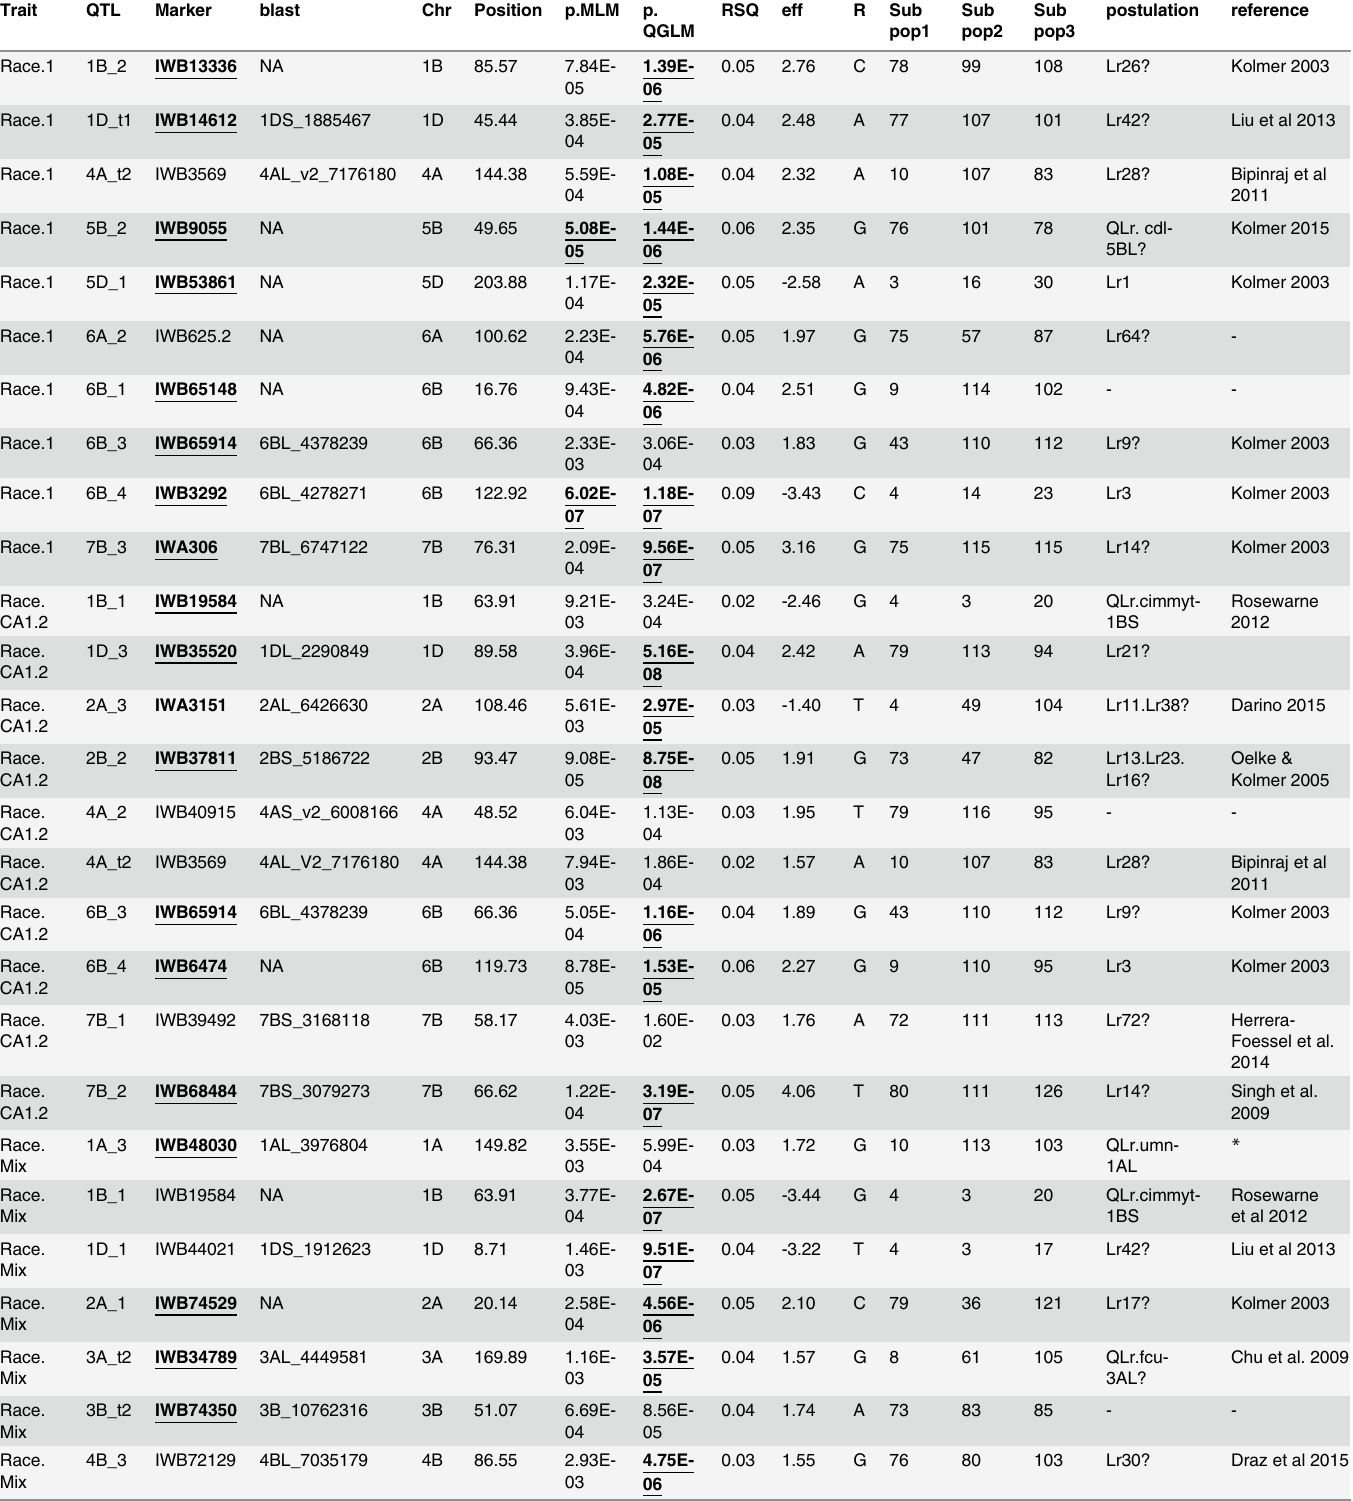
Table 3. Most significant (top 10) QTLs and representative SNPs for field and seedling traits. Trait QTL postulation